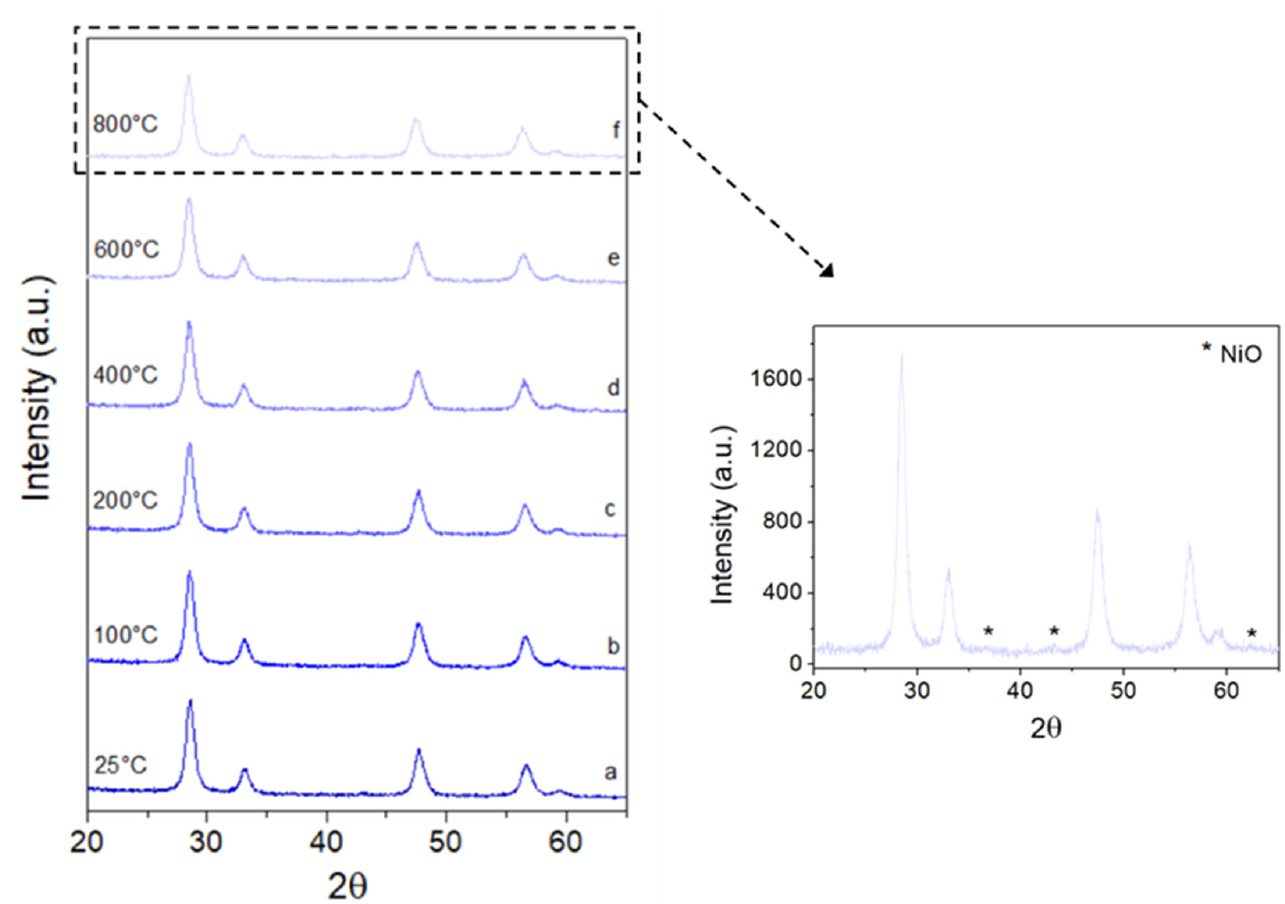
Figure 2. XRD spectra vs. temperature of doped ceria–zirconia support.